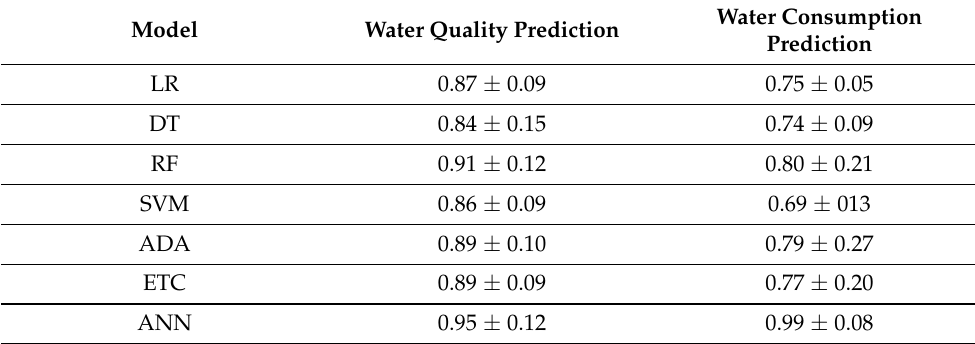
Table 13. Results using 10-fold